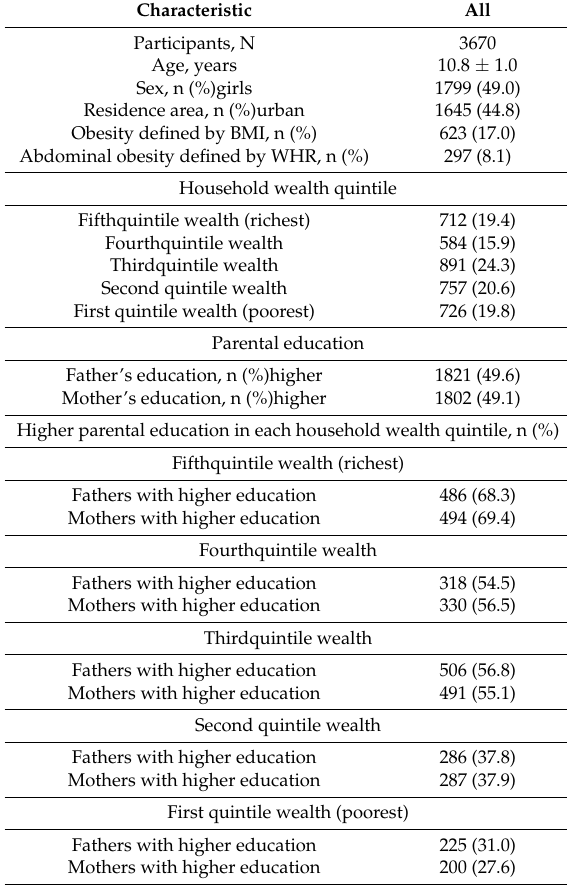
Table 3. Demographic characteristics of the 3670 children enrolled in the study.